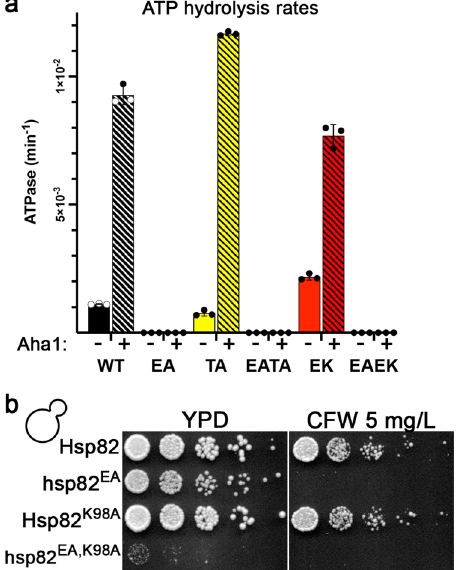
Fig. 6 | The TA and EK mutations do not restore ATP hydrolysis and advance- ment totheADPstateisimportant forviability. a The suppressormutationsTA or EK did not restore Hsp82 ATP hydrolysis when combined with EA. Bars are the average of three independent measurements (circles) and the error bars are the standard deviation. Source data are provided as a Source Data fi le. b S. cerevisiae cellsexpressingHsp82-EAcombined withtheADP-binding-speci fi cmutationK98A grew very poorly at optimal temperature compared to wild type Hsp82, Hsp82-EA or Hsp82-K98A.